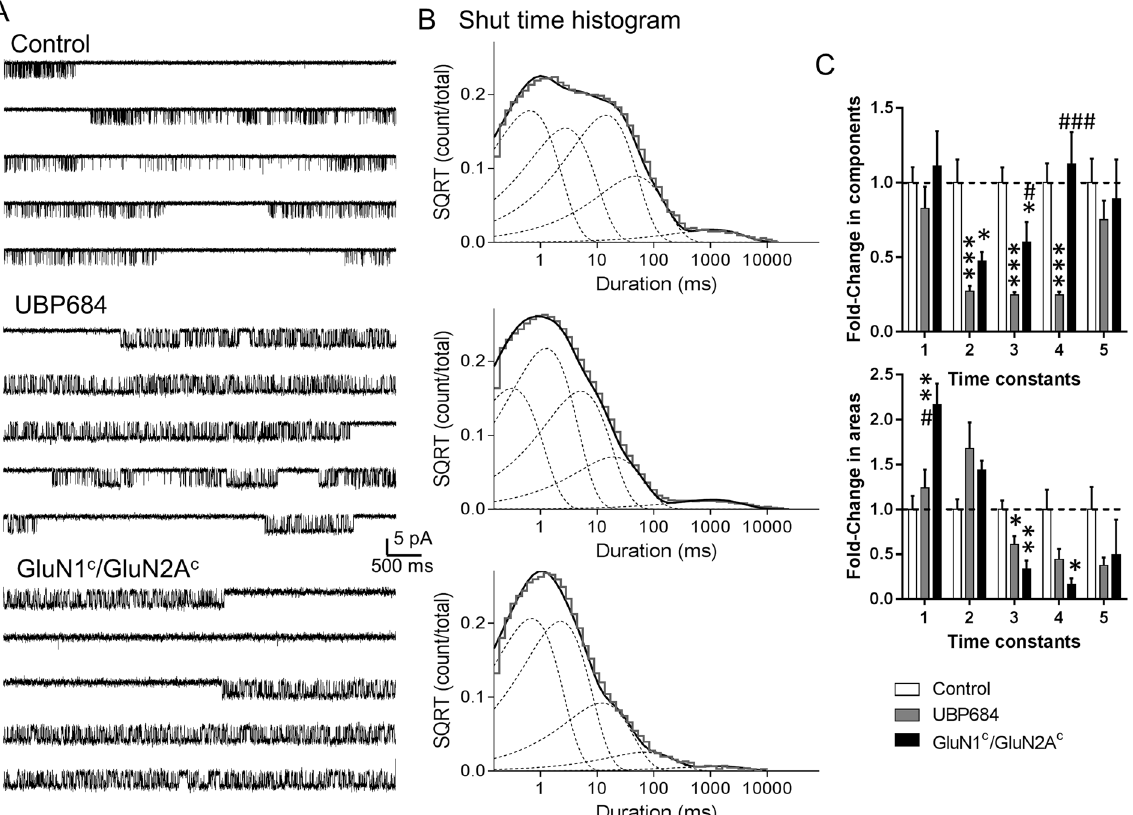
Figure 2. UBP684 induced changes in channel gating resemble effect of locking ligand-binding domain in closed conformation. Cell-attached patches containing one active channel were obtained with agonists alone (glutamate and glycine) (N = 7) or agonists plus UBP684 (N = 7) or from mutant GluN1c/GluN2Ac (N = 4) where the LBD was locked closed by engineered cysteine bridges. ( A ) Representative single-channel traces are shown. Single-channel recordings were filtered at 5 kHz (2 kHz for presentation) and digitized at 20 kHz. ( B ) Shut time histograms were fitted with 5 exponential components. Fitting of composite shut time histograms is shown. Individual shut time histograms were fitted and the changes in time constants and their areas were compared. The fold change in the normalized time constants and area of time constants is shown. Data is compared using one-way ANOVA followed by Tukey’s post-hoc analysis. * P < 0.05, ** P < 0.01 and *** P < 0.001 compared to control. # P < 0.05, ### P < 0.001 compared to UBP684. SQRT stands for square